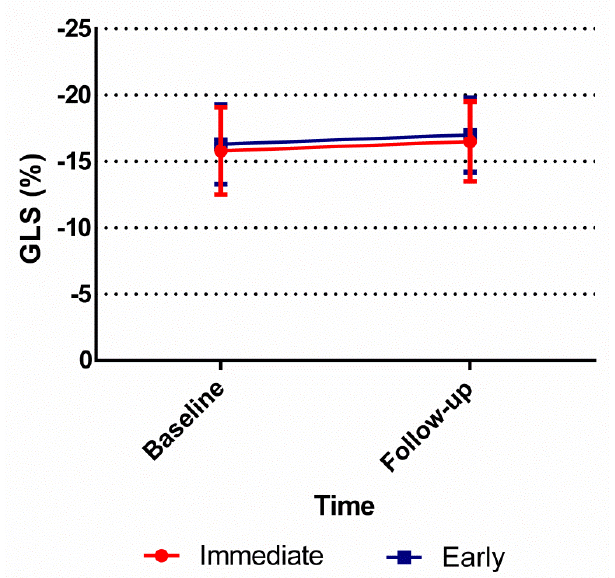
Figure 3. Global longitudinal strain improvement over time. The global longitudinal strain of both the immediate invasive strategy and early invasive strategy groups at baseline and at 30-day follow- up. GLS = global longitudinal strain.